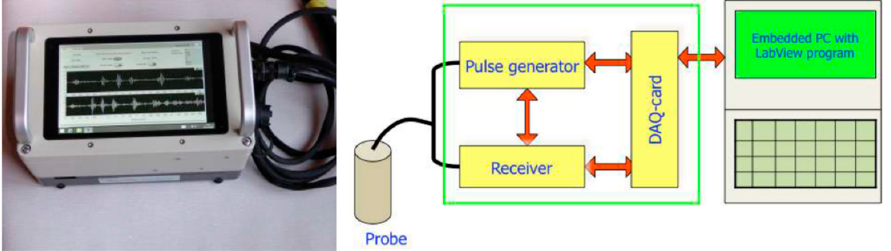
Figure 25. The portable, battery-supplied Rock Bolt Tester (RBT) instrument ( left ), and its simplified block diagram ( right ) [73].